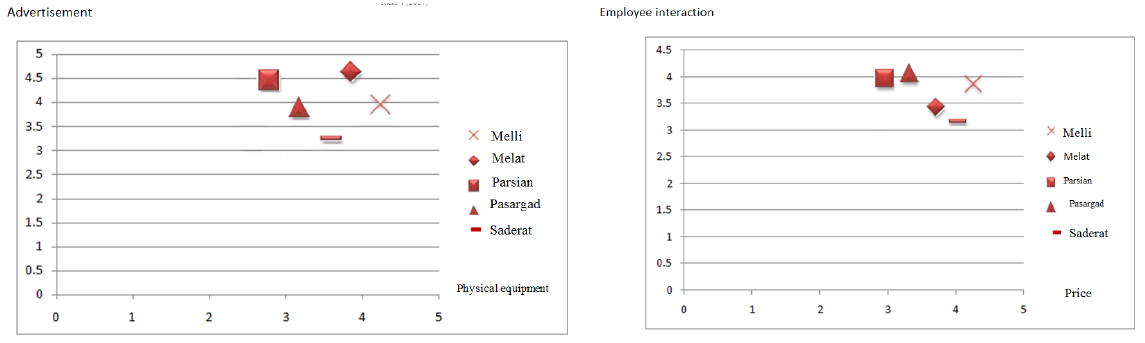
Fig. 6. The results of perceptual map for price versus physical equipment and employee interaction versus physical equipment According to Fig. 6, Melli bank is in better position in terms of price and Parargad bank is in better position in terms of employee interaction.